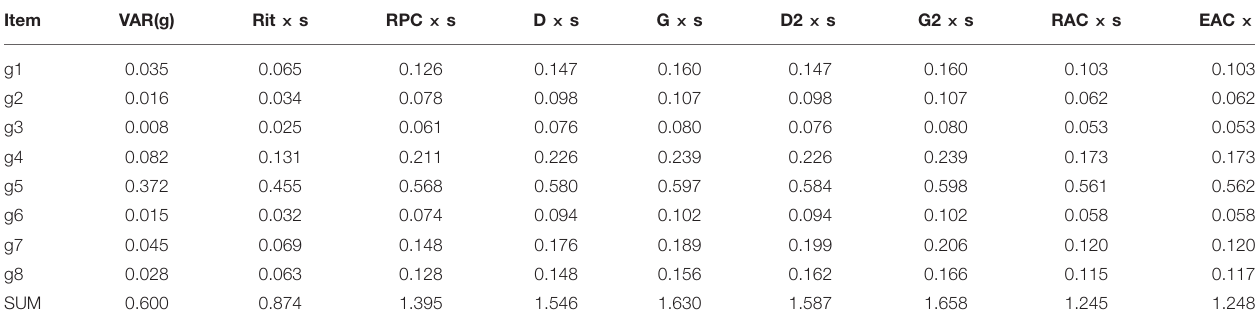
TABLE 3d | Derivatives of the estimators of correlation between an item and a raw score.